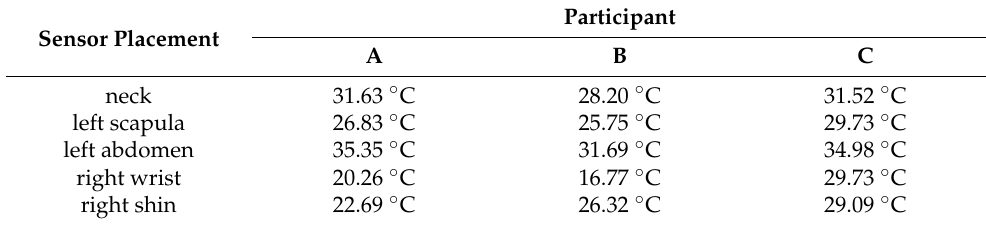
Table 5. Local skin temperature measurements at thermal